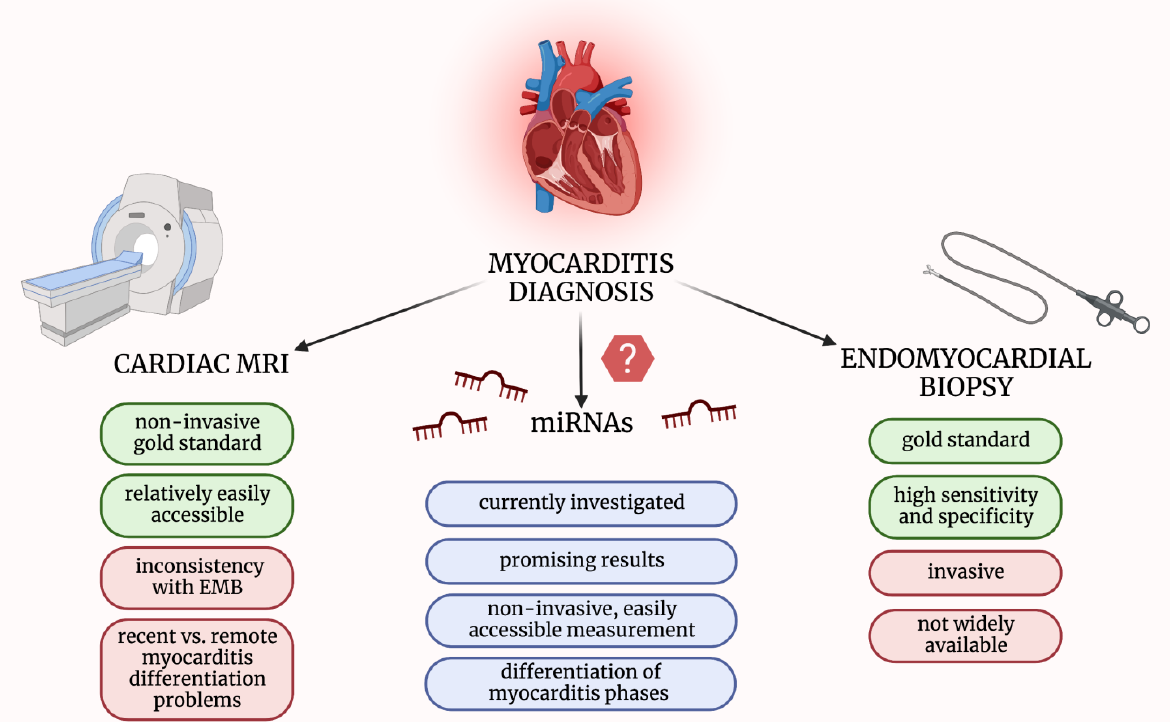
Figure 1. Comparison of methods used in myocarditis diagnosis and microRNAs’ advantages as potential diagnostic biomarkers. EMB—endomyocardial biopsy; miRNAs—micro-ribonucleic acids; MRI—magnetic resonance